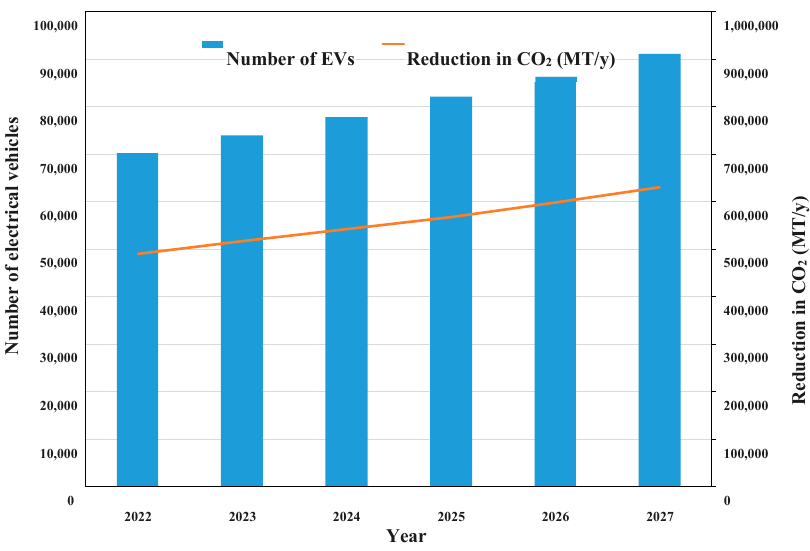
Figure 2. Impact of introducing 3% electric vehicles in a year on CO 2 emissions.